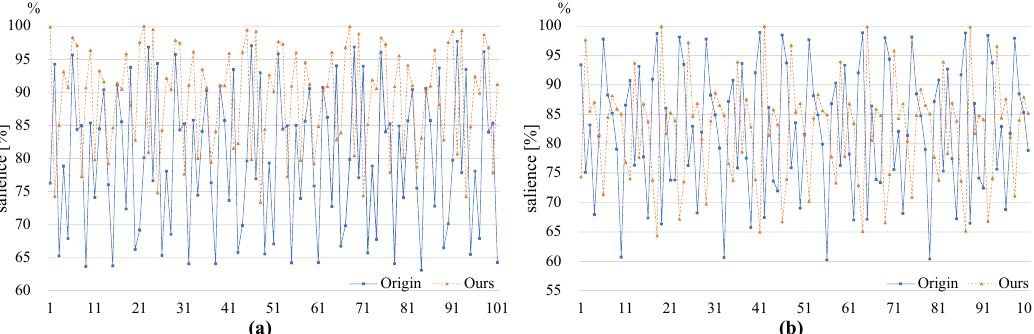
Figure 15. Salience comparison between the two evaluated algorithms. ( a ) at low object speed; ( b ) at high object